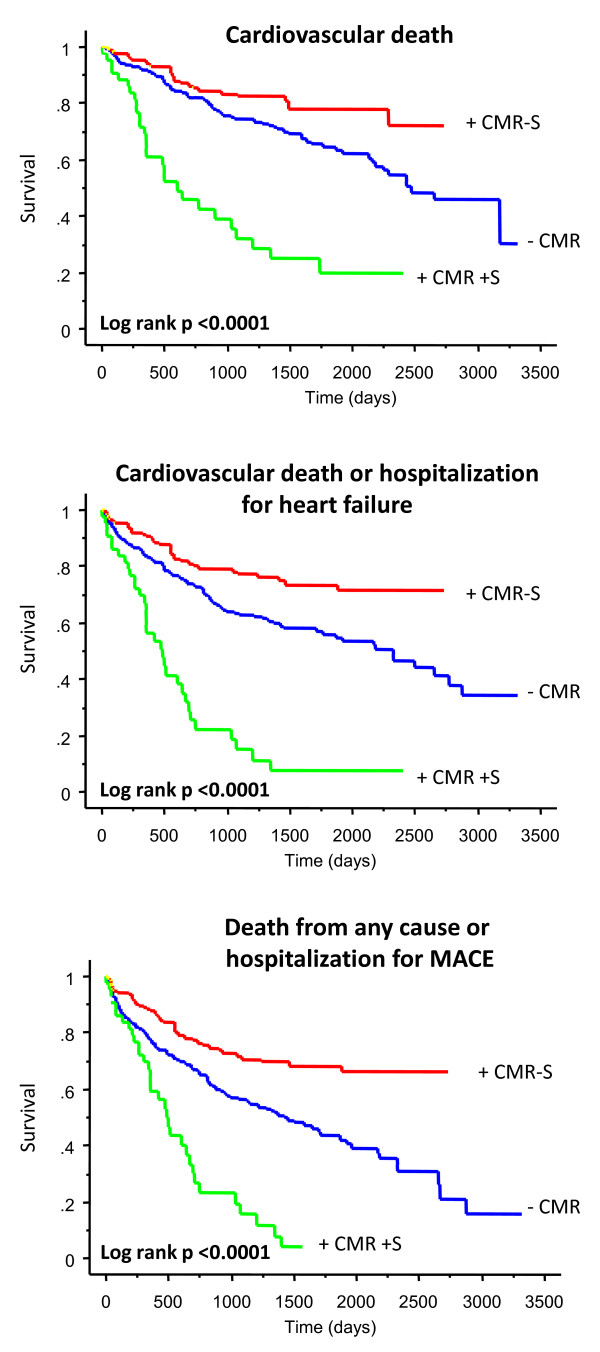
Clinical outcome of CRT according to implantation strategy. +CMR-S = group with CMR showing no scar at the LV pacing position; +CMR+S = group with CMR showing scar at the LV pacing position; -CMR = non-CMR guided group.